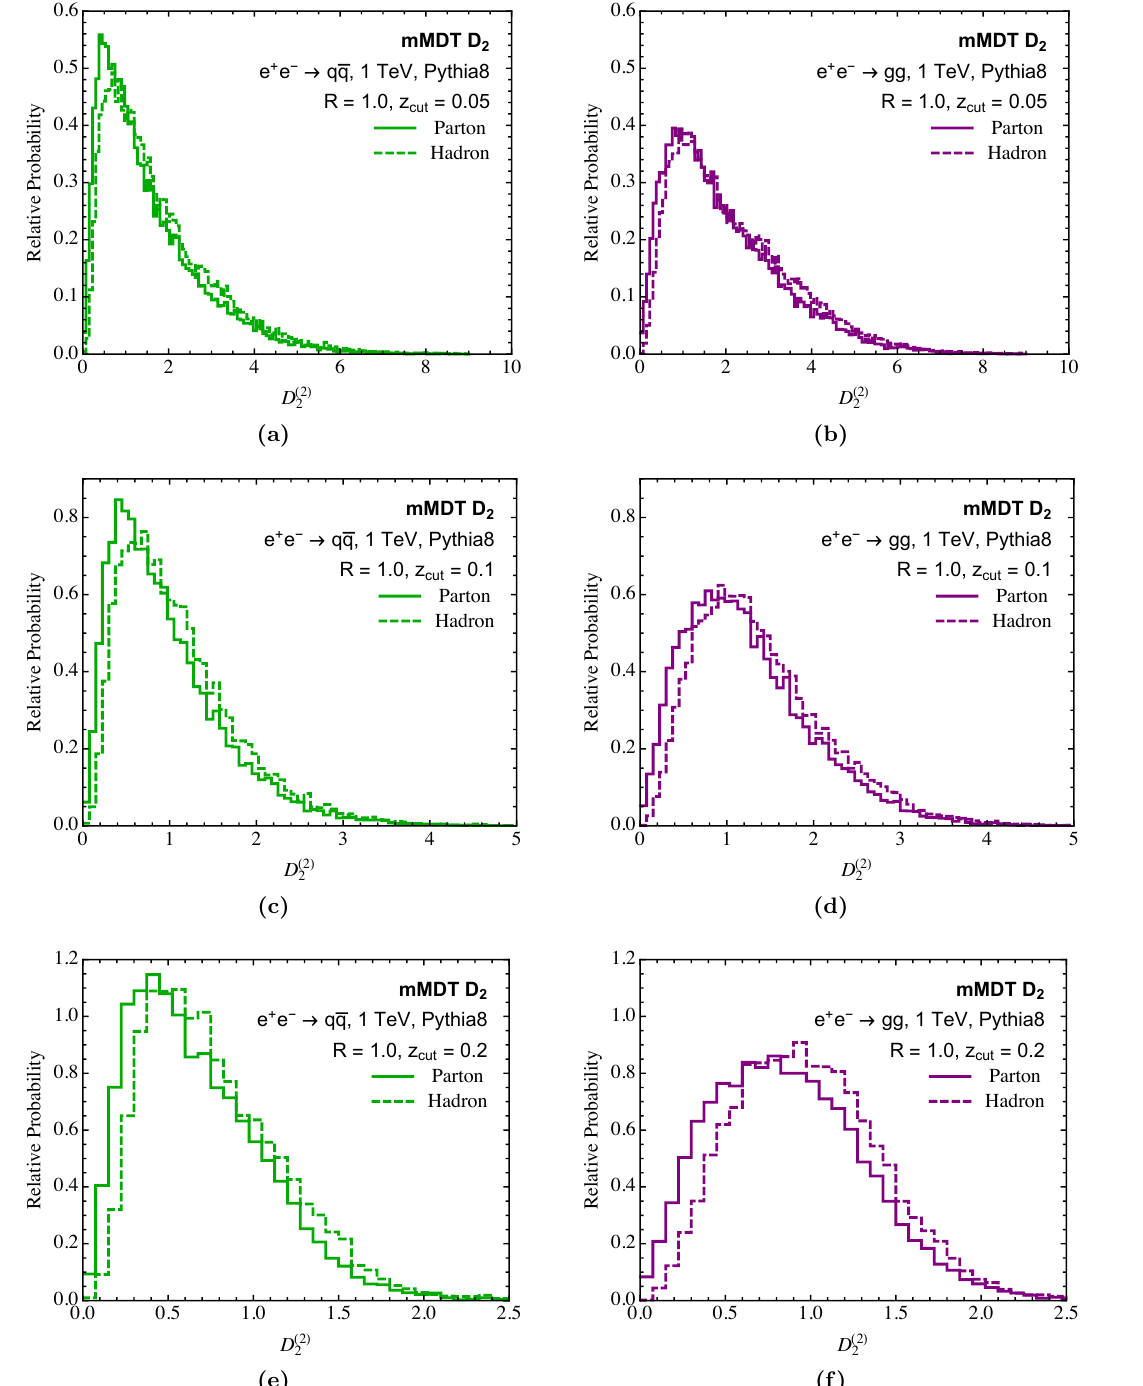
Figure 15. The e(cid:11)ect of hadronization on the D (2) distribution for quark (left column) and gluon 2 (right column) jets. Non-perturbative corrections are suppressed by the grooming procedure. A mass cut of m J [80 ; 100] GeV has been applied. 2